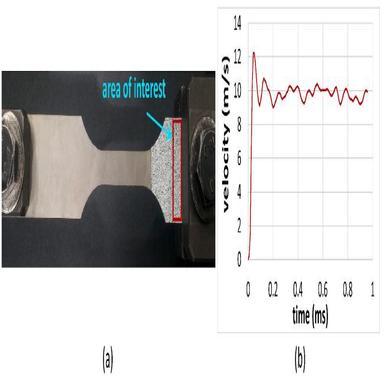
Measurement of velocity for FE boundary condition (a) speckle patterns on the pulling side (b) evolution of velocity at the pulling part of the specimen.